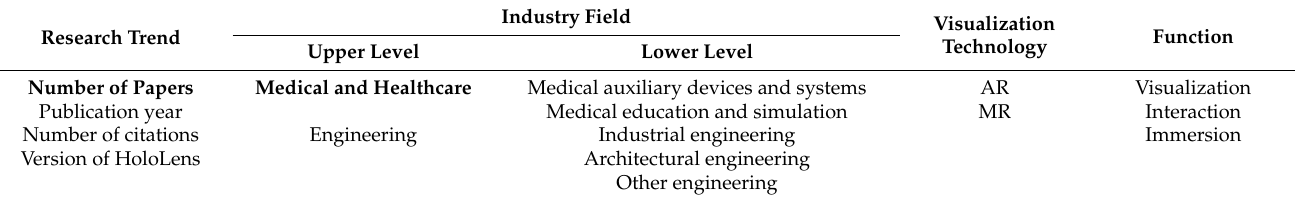
Table 1. Analysis indicators to investigate the current status and trends of research based on HoloLens. Research